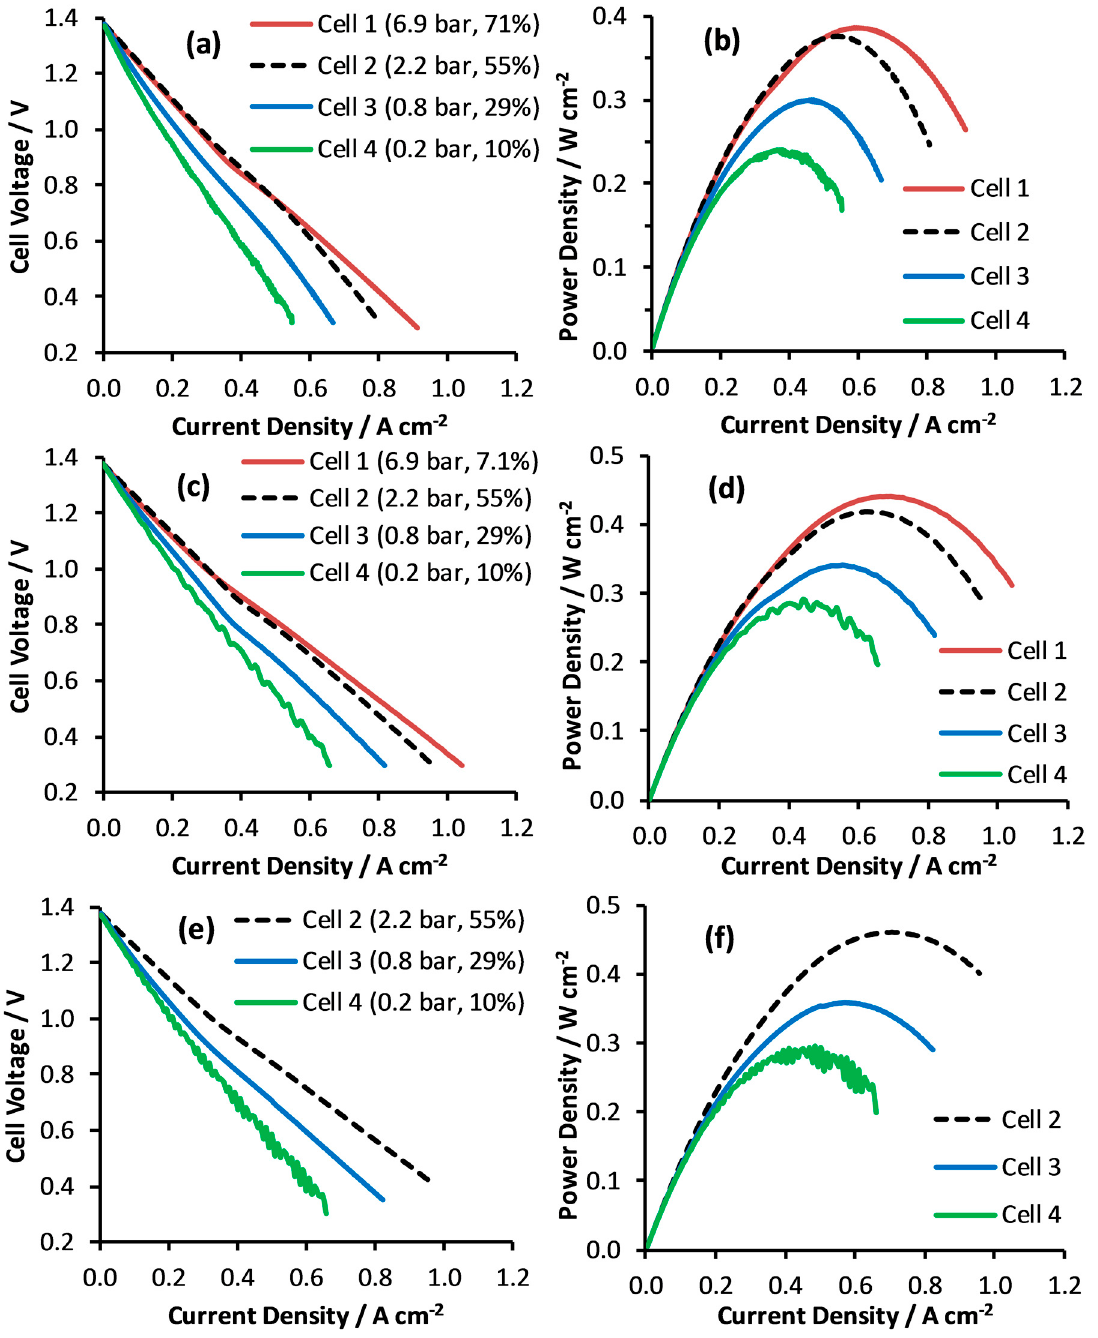
Figure A1. Transient cell performance. Cell operating voltage vs. current density for Cells 1–4 (labeled) at flow rates of ( a ) 50 mL min − 1 , ( c ) 100 mL min − 1 and ( e ) 200 mL min − 1 . Cell power density vs. current density for Cells 1–4 (labeled) at flow rates of ( b ) 50 mL min − 1 , ( d ) 100 mL min − 1 and ( f ) 200 mL min − 1 . Felt compression pressures and % compression values for each cell are given in brackets.